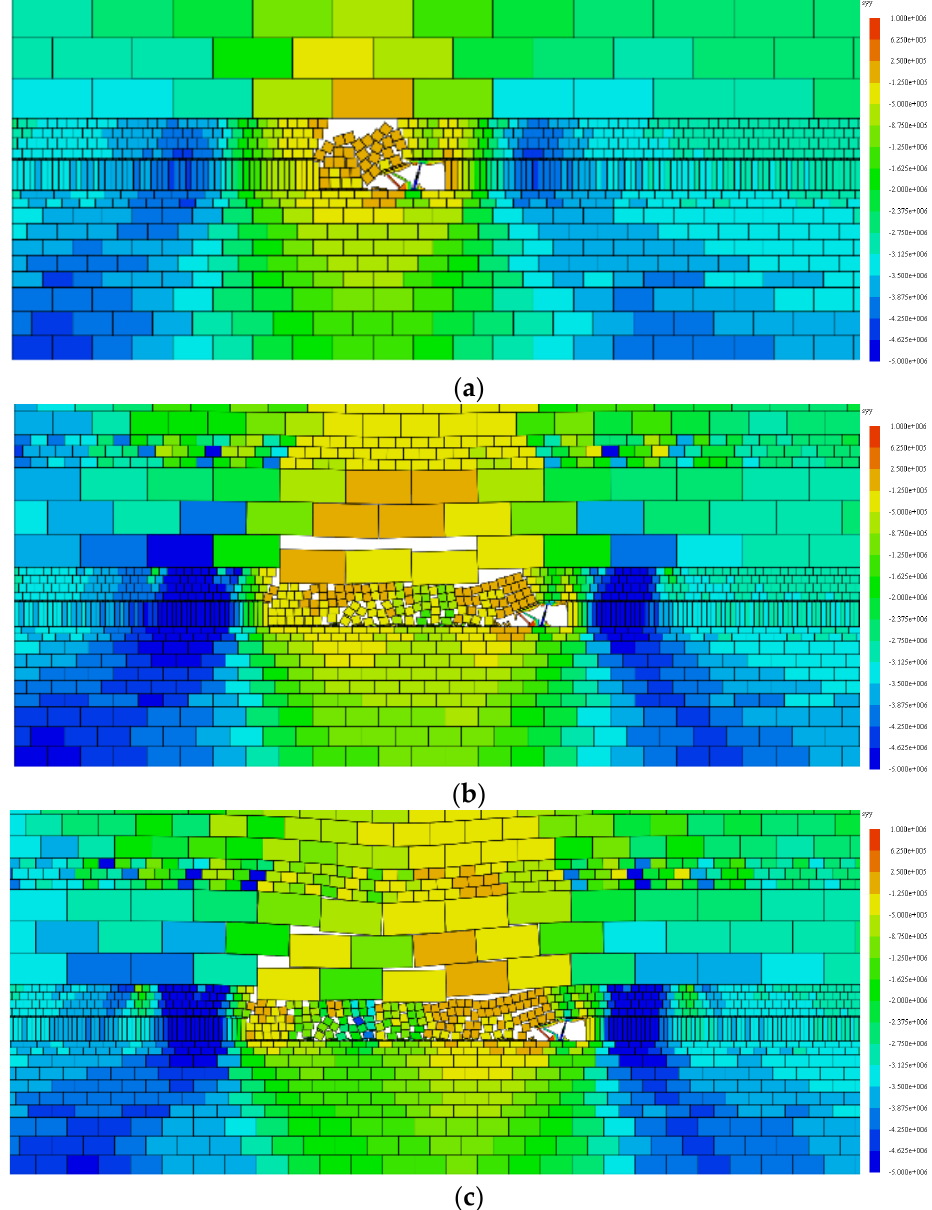
Figure 3. Overlying strata movement and deformation of different excavation distance. ( a ) Immediate roof collapse, ( b ) First collapse of basic roof, ( c ) Second collapse of basic roof.